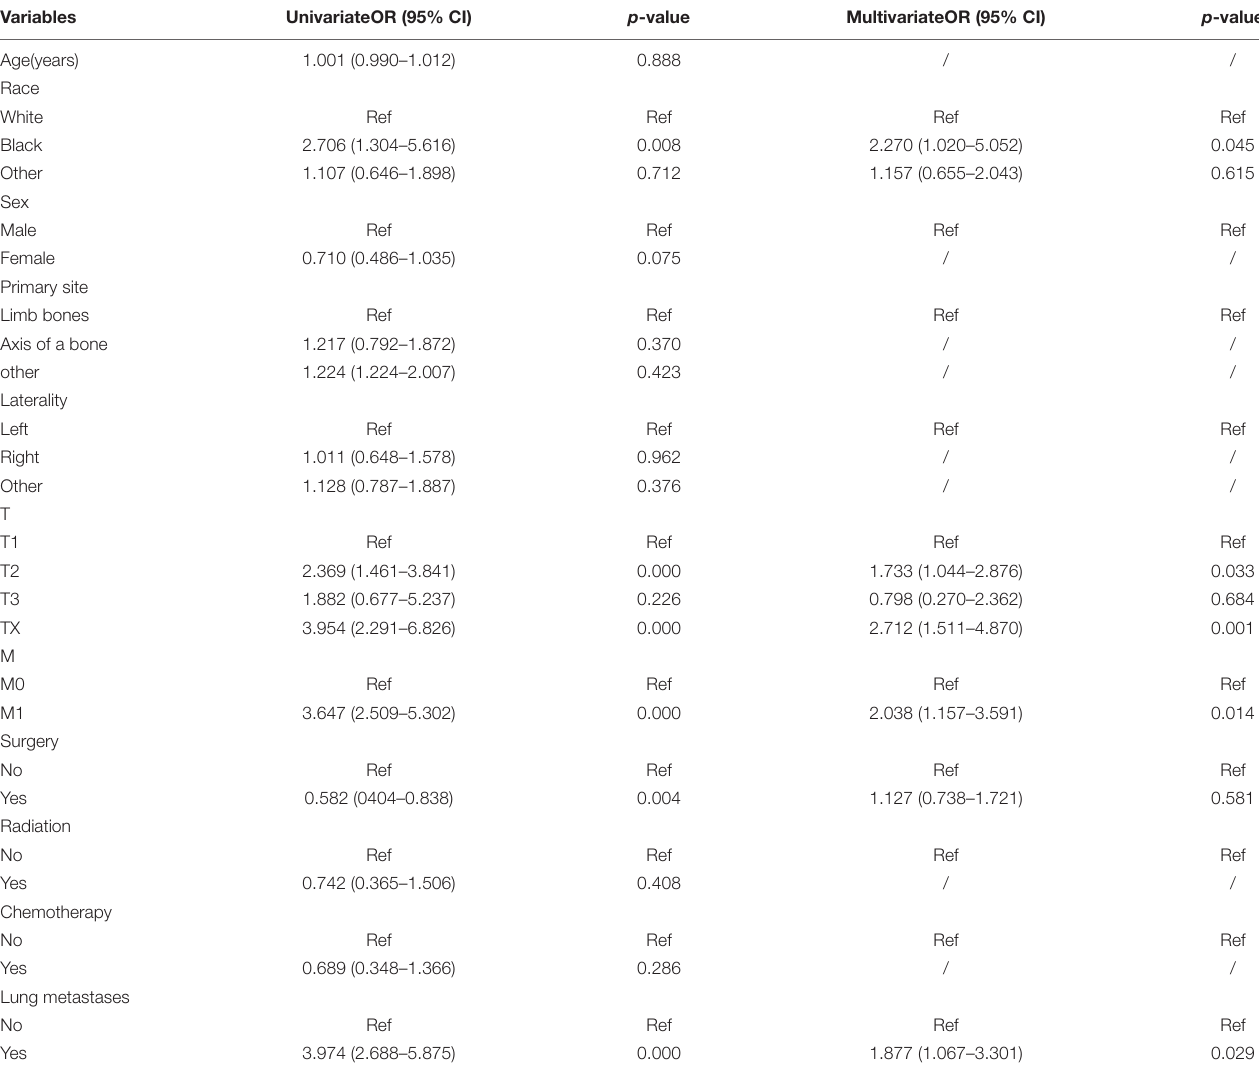
TABLE 3 | Univariate and multivariate logistic regression analysis of risk factors for Lymph node metastases in patients with Ewing